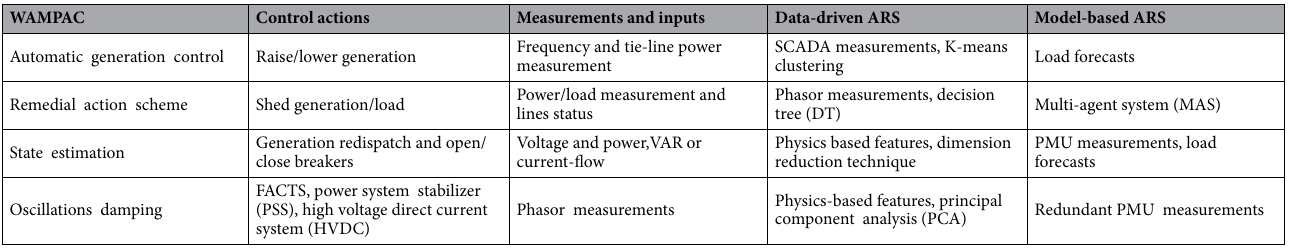
Table 4. Control actions of ARS for different WAMPAC applications.